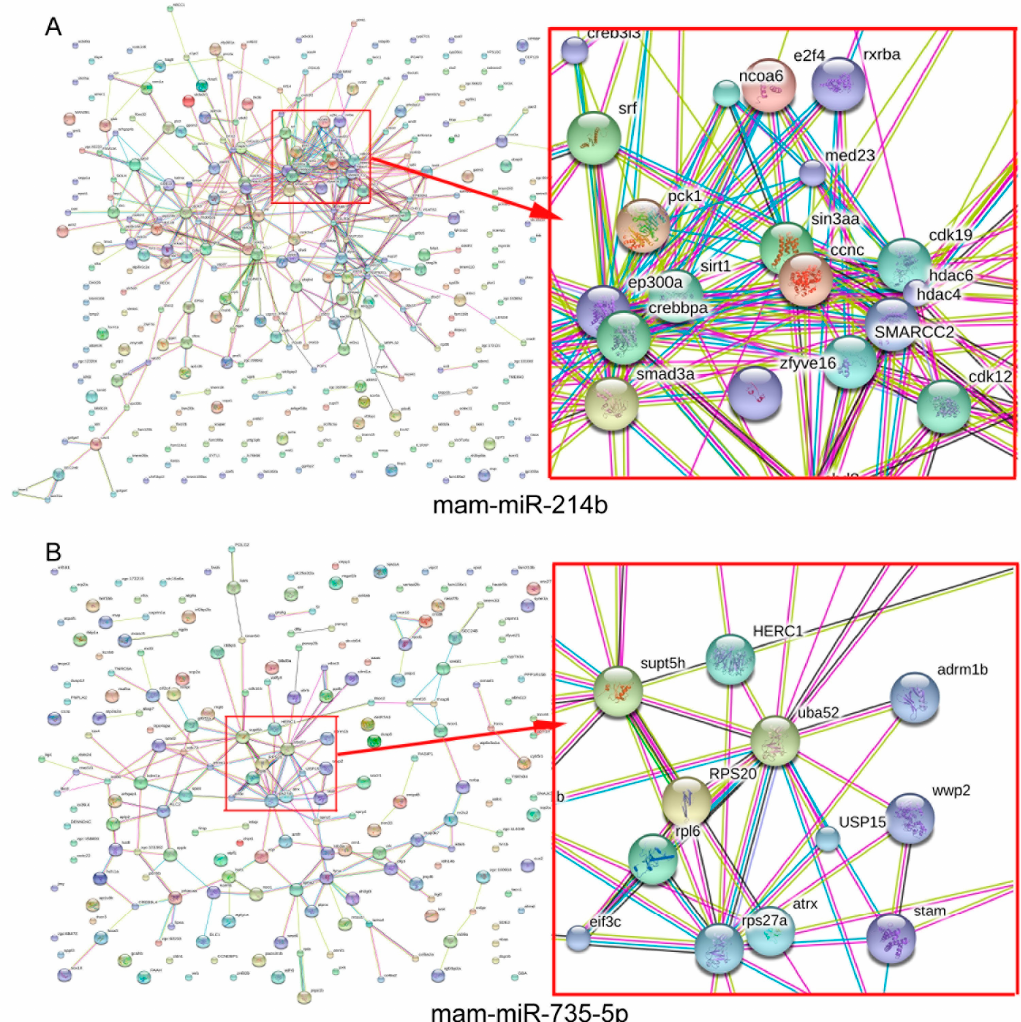
Figure 6. Protein–protein interaction (PPI) networks for the predicted targets of differentially expressed mam-miR-214b and mam-miR-735-5p in M. amblycephala . Network nodes represent proteins, and edges represent protein–protein associations.